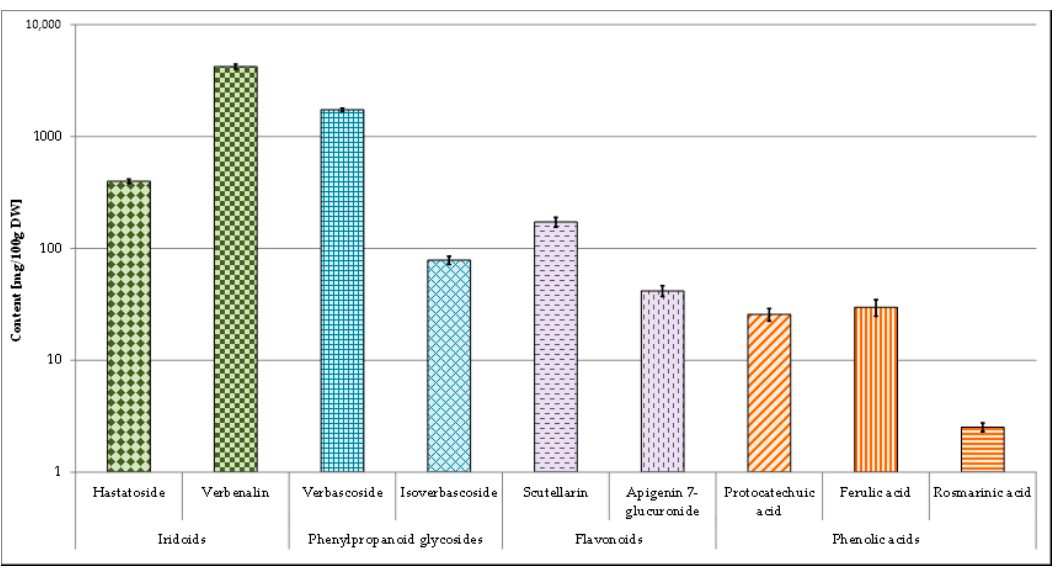
Figure 3. Iridoids, phenylpropanoid glycosides, flavonoids and phenolic acids contents (mg/100 g DW ± SD) in extracts of V. officinalis plant material.